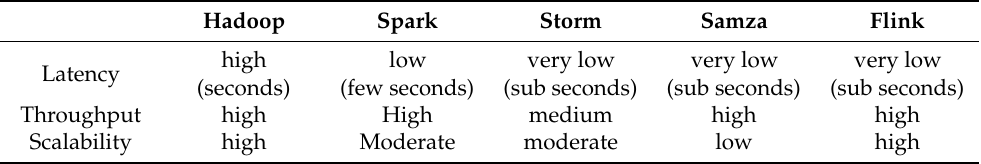
Table 6. Comparison of big data frameworks with respect to performance related features.